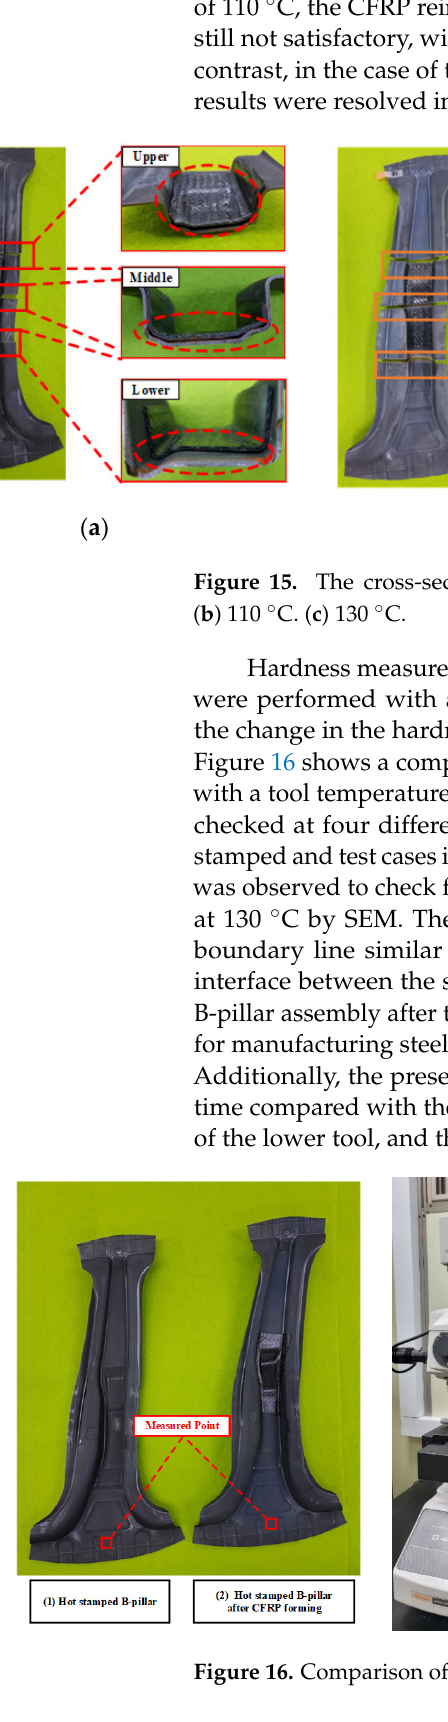
Figure 17. Observation results of the interlayer behavior by SEM. 5. Conclusions In this study, a steel/CFRP B-pillar assembly was manufactured using the PCM pro- cess without an additional adhesive process. The process design method was proposed based on the FE simulation, and the results are as follows. The B-pillar was manufactured using a hot stamping process, wherein the conditions were determined using FE simula- tion. The results of the formability evaluation indicated that there were no problems dur- ing hot stamping. The B-pillar has high dimensional accuracy, as shown in the comparison results of the spring-back between the FE simulation and target model. Therefore, the de- signed B-pillar can be used as a tool for the PCM process. The thermoplastic CFRP prepreg hardened immediately when the temperature of the CFRP decreased below T g owing to the heat transfer between the tool and laminate. Therefore, the temperatures of the tools